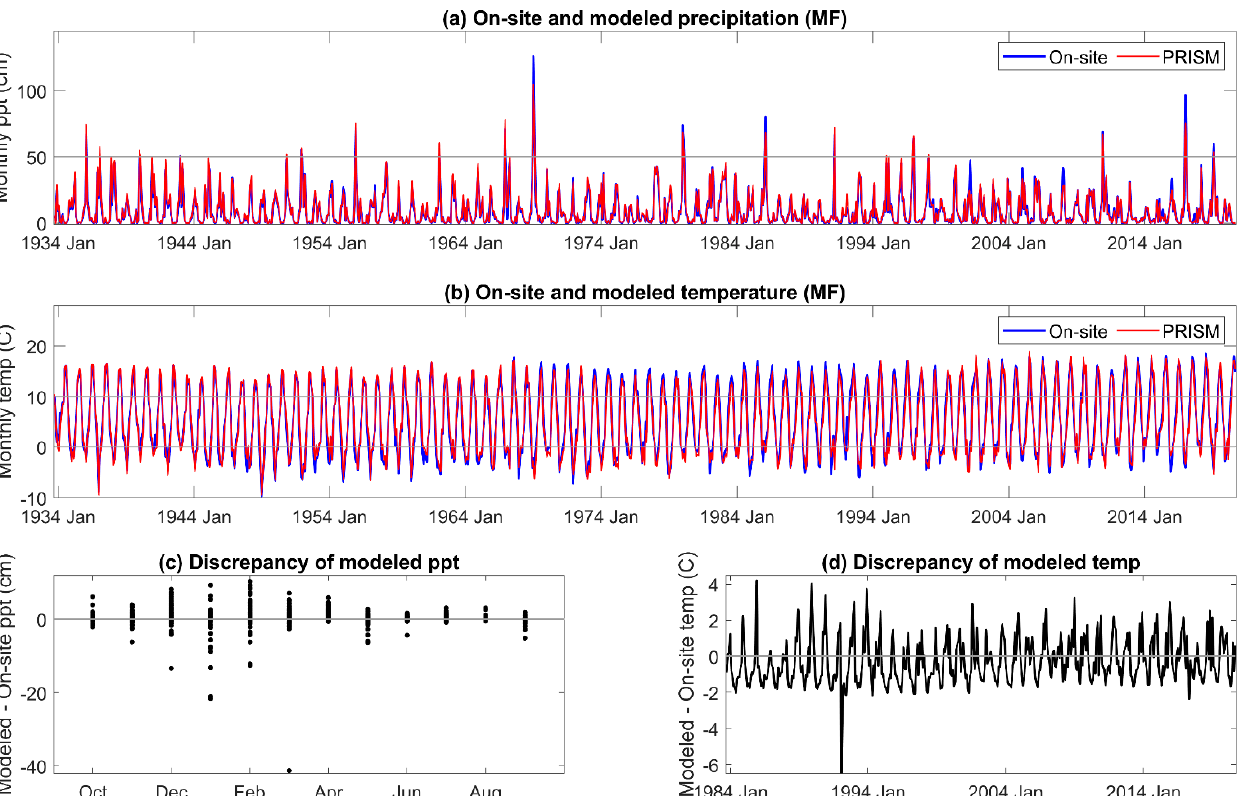
Figure 2. Comparison of on-site vs. PRISM ( a ) precipitation; ( b ) mean air temperature; ( c , d ) and discrepancies between the two at site MF.